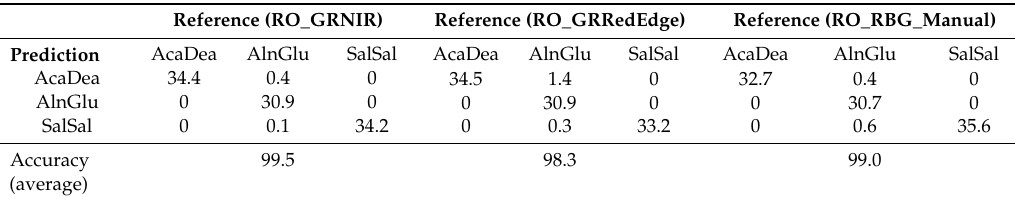
Table 2. Confusion matrix based on 100 bootstrap replicates. In each replicate, 99 random points are selected with replication as train data and the remaining points ( ± 32 to 41 points) are used to